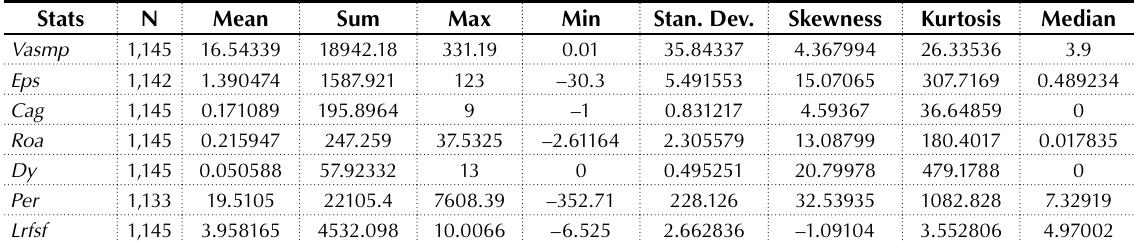
Table 2. Descriptive statistics (Value Stock